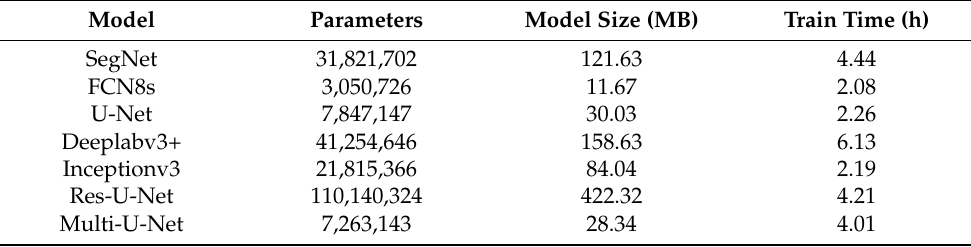
Table 3. Comparisons of network efficiency among the tested deep learning models. Parameter is the number of parameters needed for model